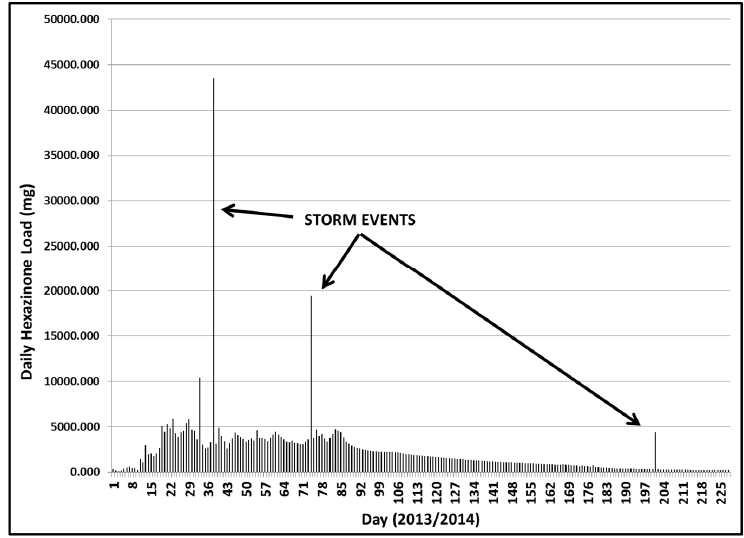
Figure 12. Year 2—daily loadings of hexazinone in the Rangitaiki River at the Rangitaiki flow gauge.